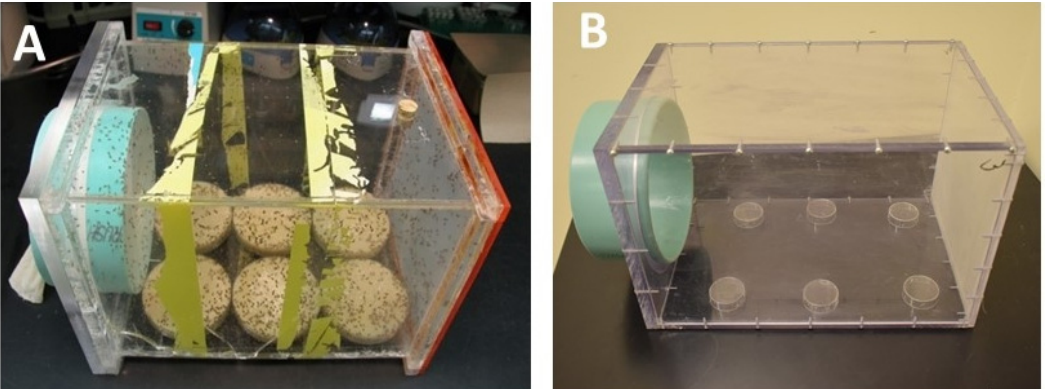
Figure 1. The egg-laying cage measuring 300 mm × 200 mm × 200 mm. ( A ) An egg-laying cage holding ~10,000 flies, which contains six plates of cornmeal-sucrose-yeast medium. ( B ) An empty egg-laying cage showing the six small (35 mm × 10 mm) plastic Petri dish bottom halves taped upside-down onto the bottom of the cage using double-sided tape.